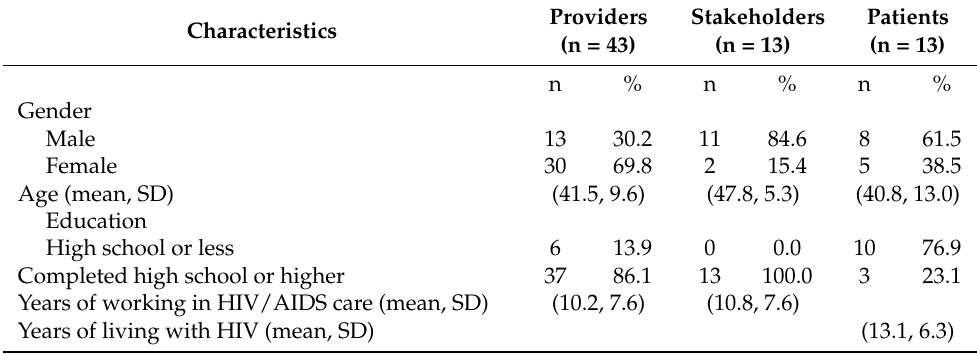
Table 1. Demographic characteristics of study volunteers, Cambodia CE research project (n = 69), Cambodia,